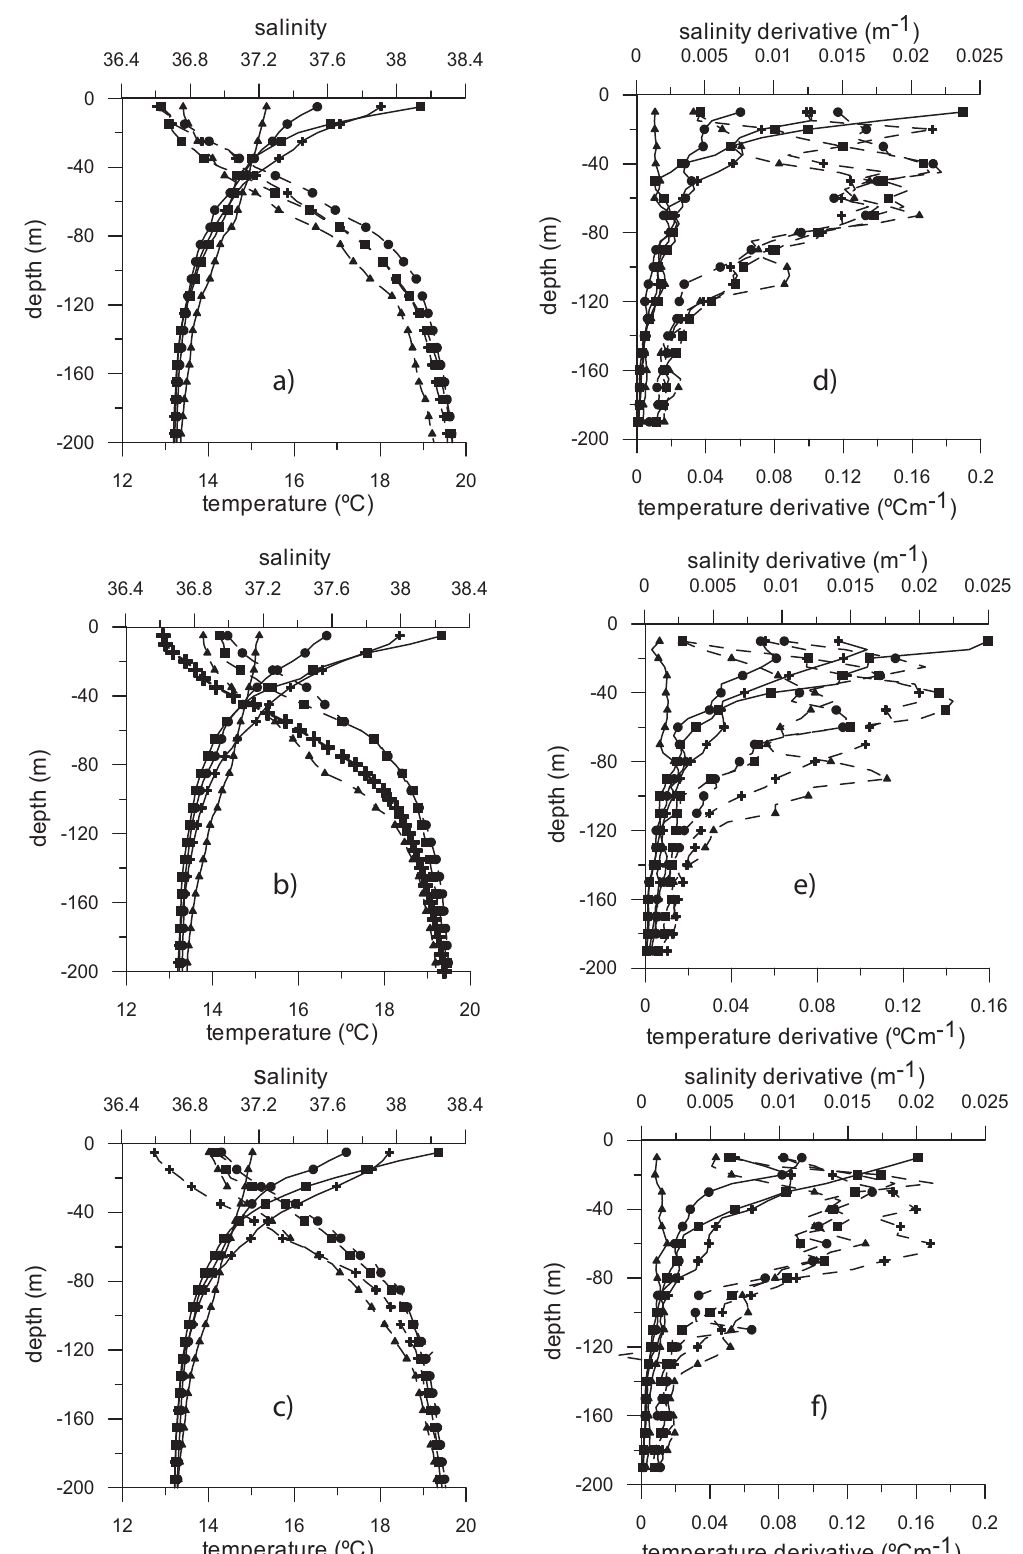
Fig. 2. – Temperature (solid line) and salinity (dashed lines) mean profiles at P3, M3 and V3 (a, b and c respectively). In all the cases we have obtained a profile for each season of the year. Squares correspond to summer (July-September), crosses to autumn (October-December), triangles to winter (January-March) and circles to spring (April-June). Figures 2d, e, f . Vertical derivatives of temperature and salinity. Line and symbol criteria are the same as in Figures a, b,